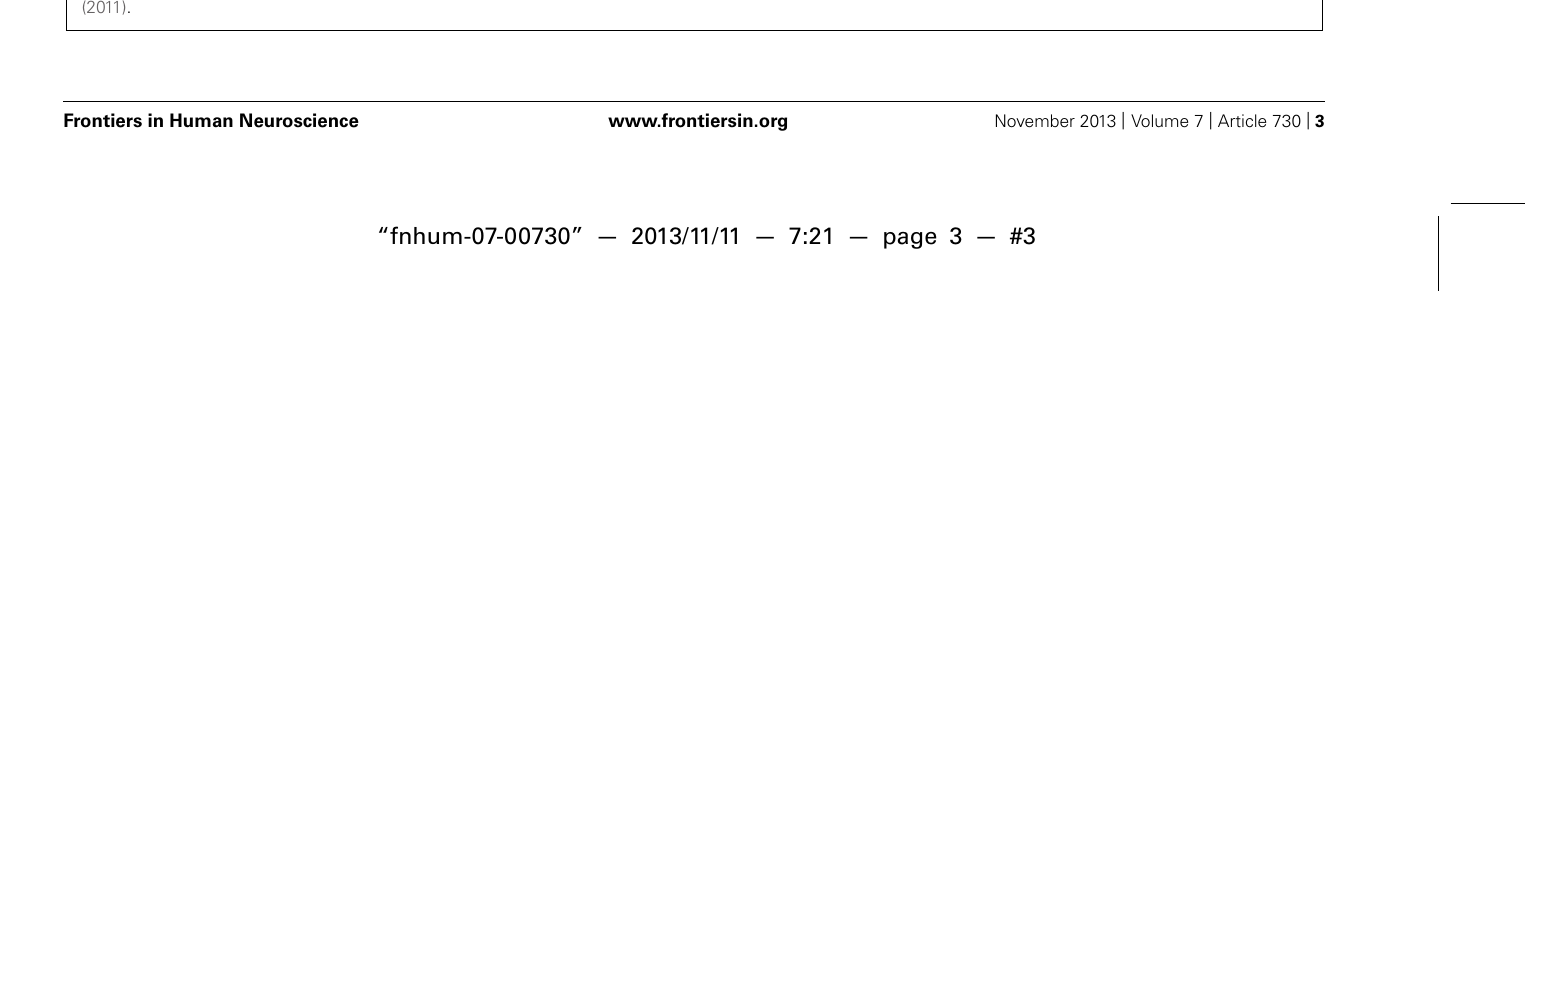
FIGURE 2 | Modulation of cortical activity by aesthetic rating. Averaged parameter estimates showing modulation by beauty rating (beautiful, indifferent, and ugly) in mOFC for (A) visual stimuli and (B) musical stimuli. A linear relationship with beauty rating was observed in both conditions. From Ishizu and Zeki